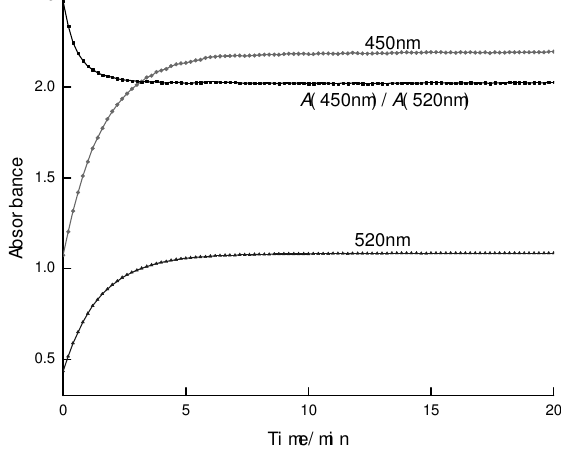
Figure 2. Plots of reaction time vs. absorbance of